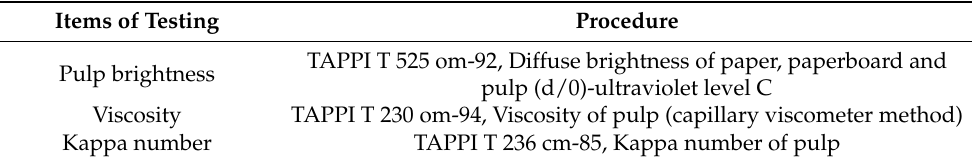
Table 1. The test methods of pulp quality.